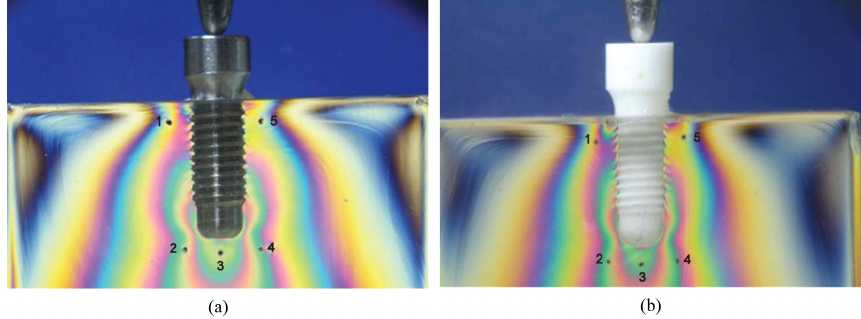
Figure 5. Comparison between photoelasticity observed in the titanium (a) and zirconia (b) implants under a load of 200N. Table 1. Comparison of mean stress (standard deviation) (MPa) for titanium and zirconia cylinders (2-way ANOVA, Bonferroni, p < .05).